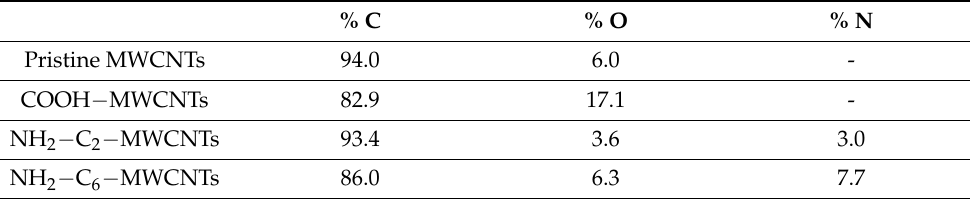
Table 1. Chemical composition in surface atomic percent for pristine MWCNTs, COOH − MWCNTs, and NH 2 −